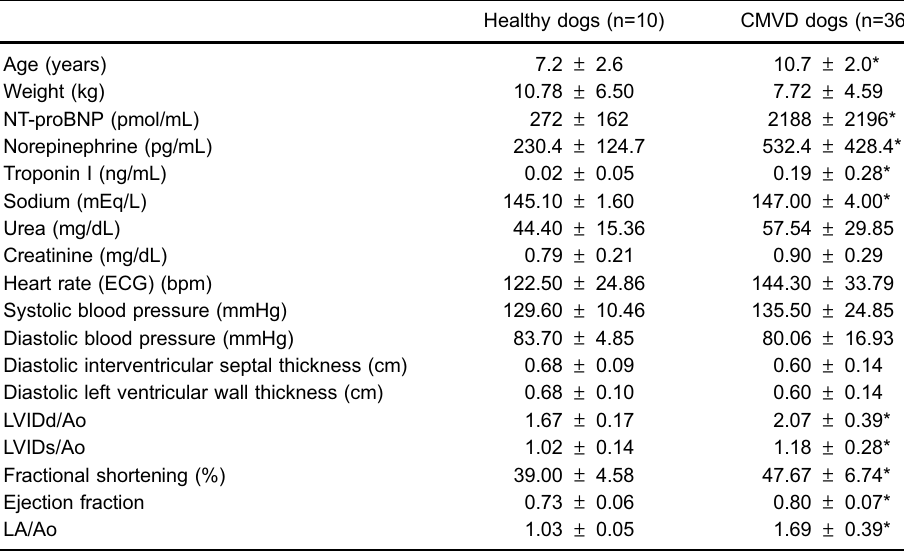
Table 1. Baseline clinical, laboratory, and echocardiographic values for healthy dogs and dogs with chronic mitral valve disease (CMVD).